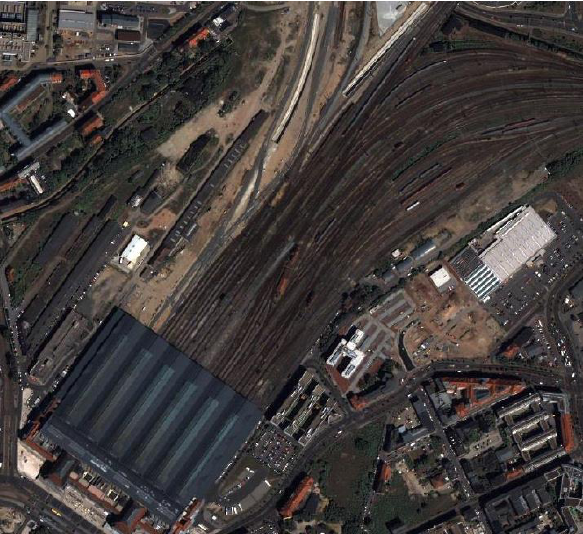
Figure 2. Results of Gram-Schmidt Pan-sharpening, the city of